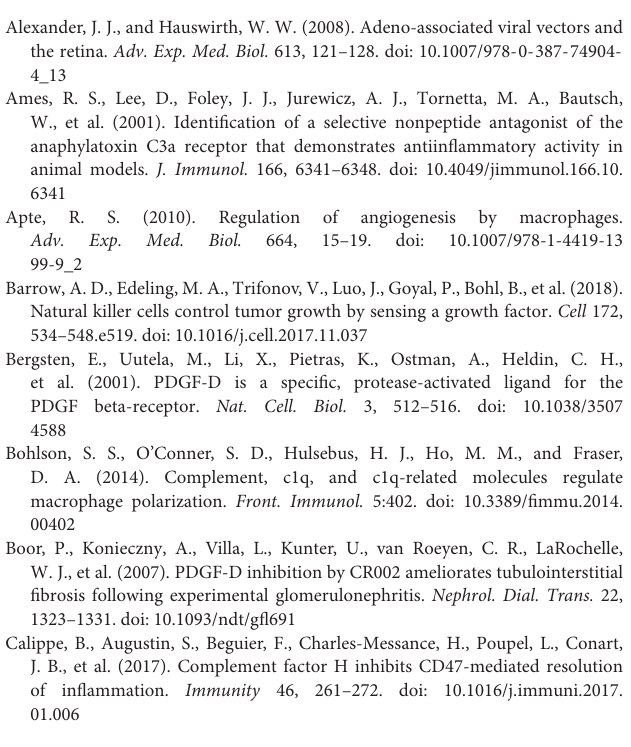
Supplementary Figure 2 | PDGF-D-induced RPE secretome promotes macrophage migration. (A) Immunoblot showing the activation of PDGFR- β by Scale bar: 400 µ m. All the experiments were performed in triplicates. * p < 0.05, ** p < 0.01, *** p < 0.001. Supplementary Figure 3 | Expression of PDGF-D receptors in mouse retina and choroid. (A) Real-time PCR results showing expression of PDGF receptors in retinae and RPE-choroid complex of normal C57BL6 mice. (B) Immunoblot analysis showing PDGF receptor expression in normal mouse retinae and RPE-choroid. (C) Immunofluorescence staining reveling PDGF receptor